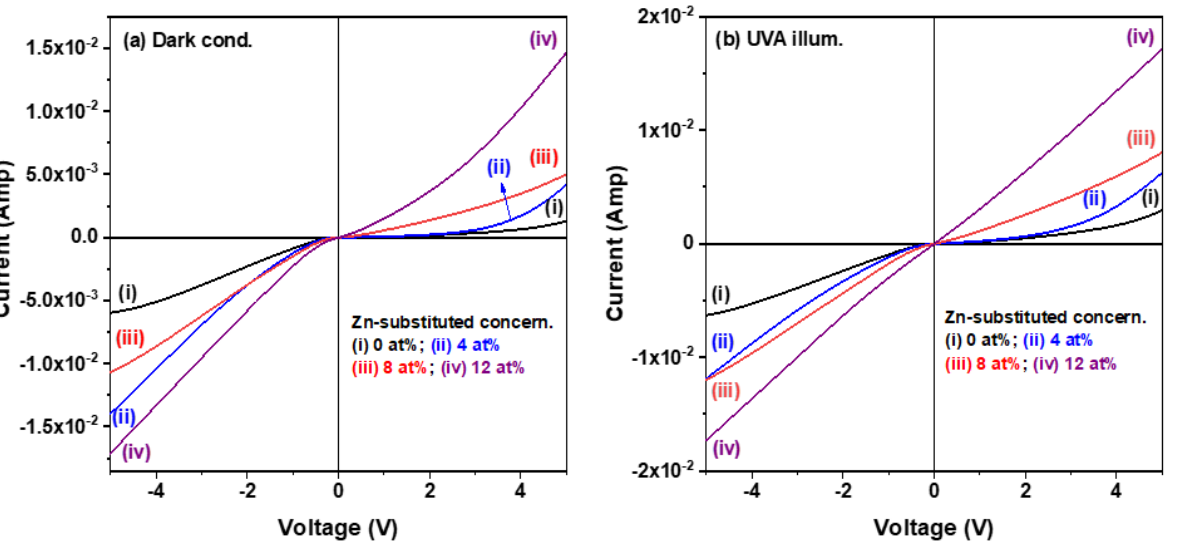
Figure 6. Comparison of current − voltage (I–V) characteristic curves of the CuI-based MSM photodetectors: ( a ) in a dark environment and ( b ) under UVA light illumination.